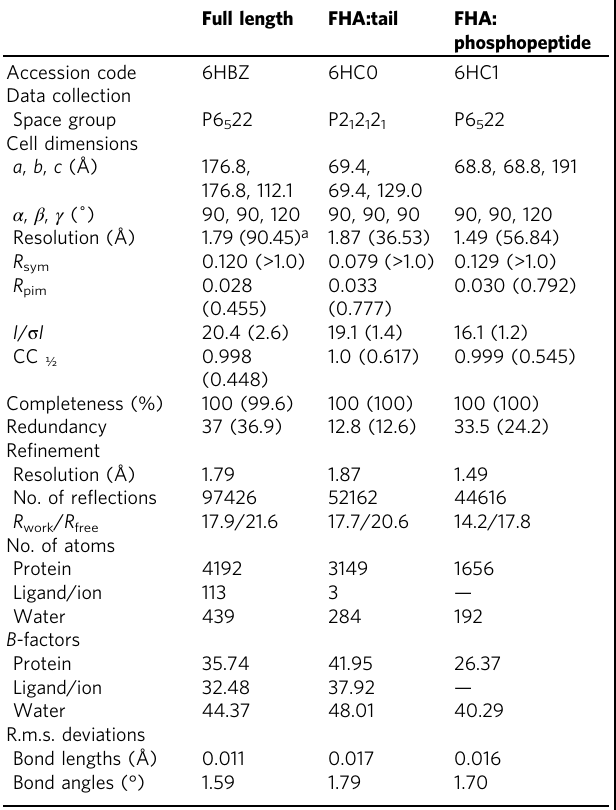
Table 1 Data collection and re fi nement